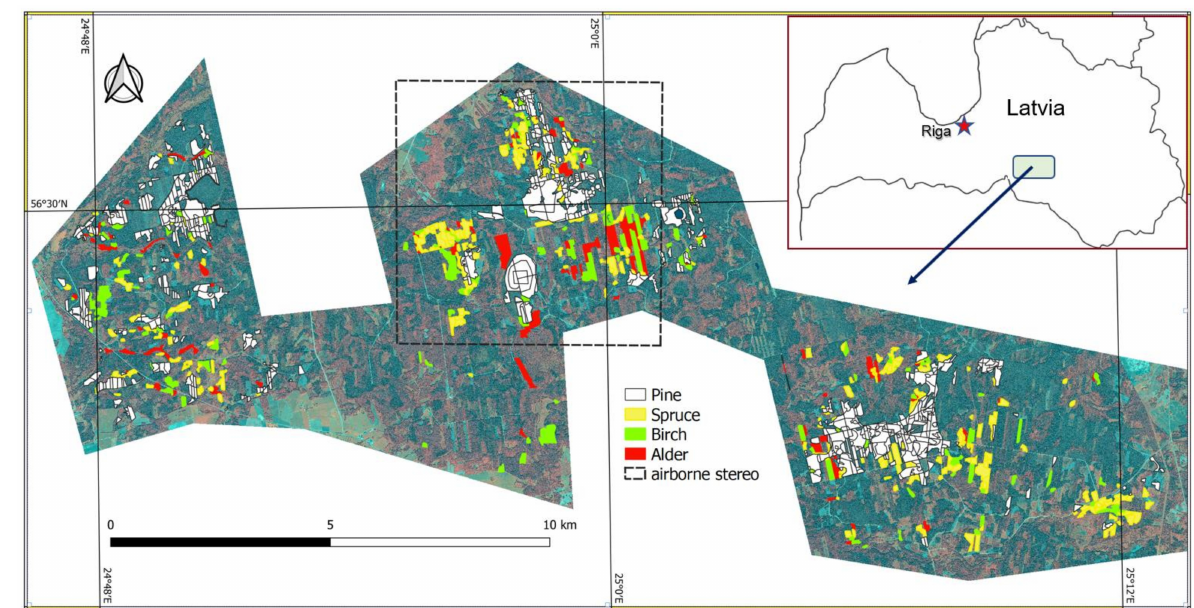
Figure 1. The 350 km 2 study area is represented by dense, closed-canopy deciduous, and evergreen forestland (GeoEye NIR-R-B orthophoto). The polygons represent the locations of chosen forests study plots, separated by four dominant tree species. Table 1. Characteristics of stereo satellite imagery pairs (Pleiades and GE1) and airborne (UltraCam) acquired at the